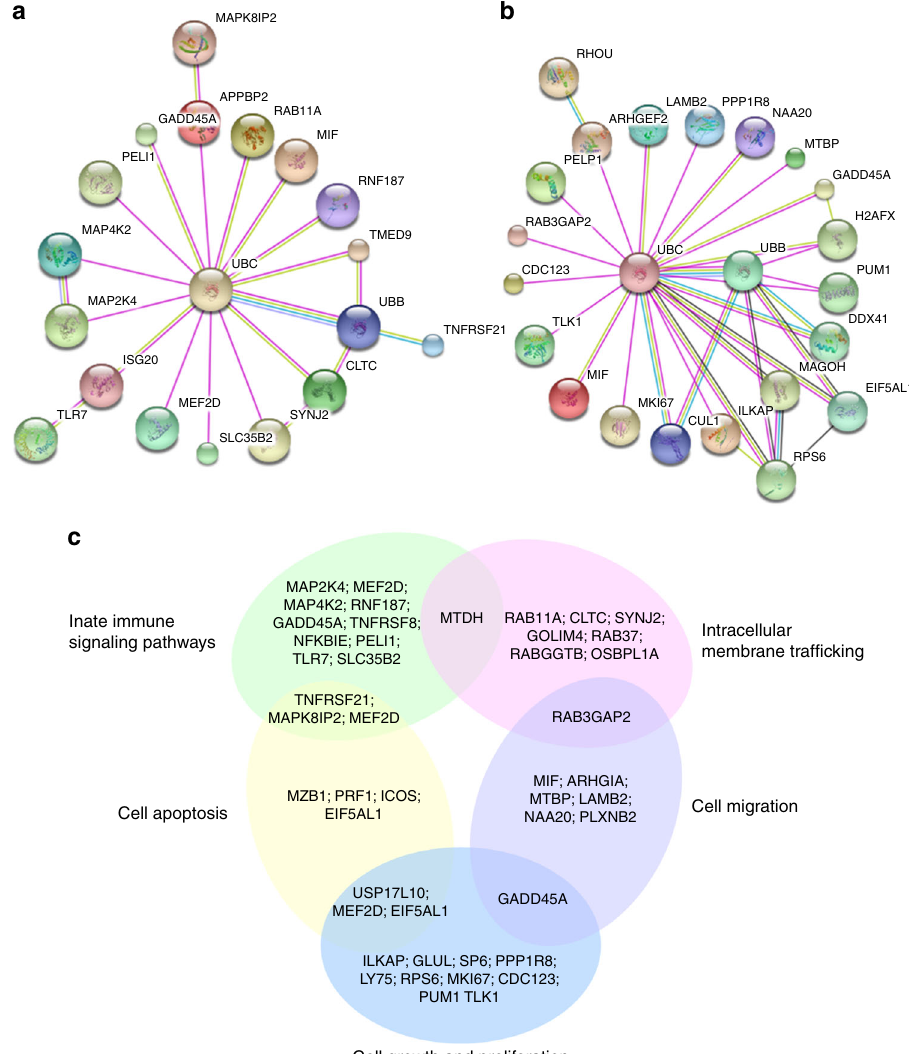
Fig. 3 Network analysis of proteins potentially regulated by PtpA. a A subnet of candidate PtpA-regulated proteins involved in the signaling pathways of the innate immune system. b A subnet of candidate PtpA-regulated proteins involved in cell proliferation and migration. c Classi fi cation of candidate PtpA- regulated proteins, whose gene promoter regions ( ± 2 kb from the TSS) were potentially regulated by